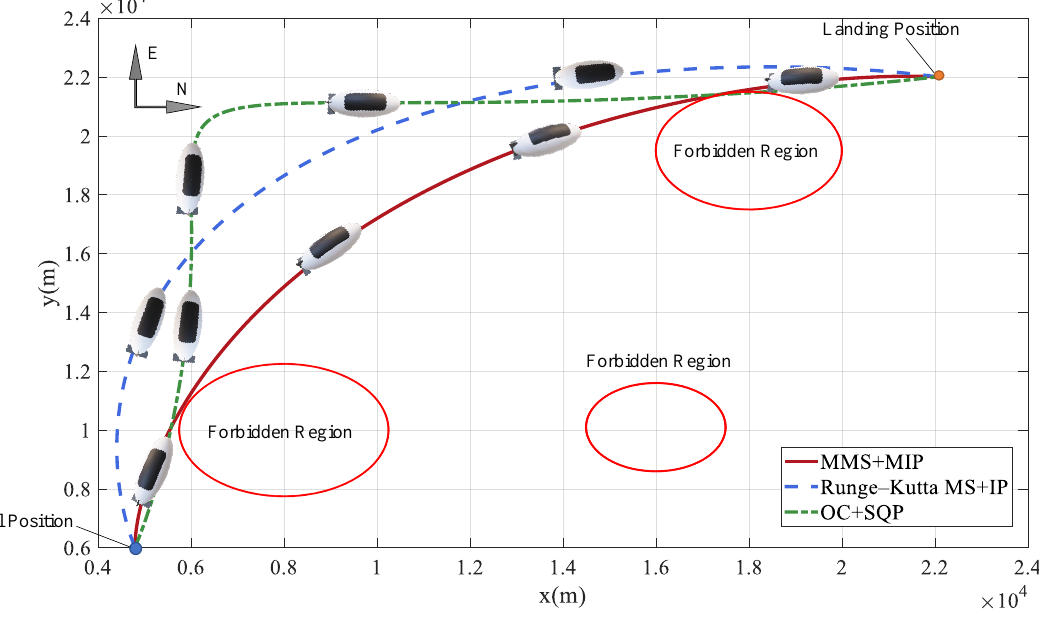
Figure 13. Top view of optimized trajectories between different